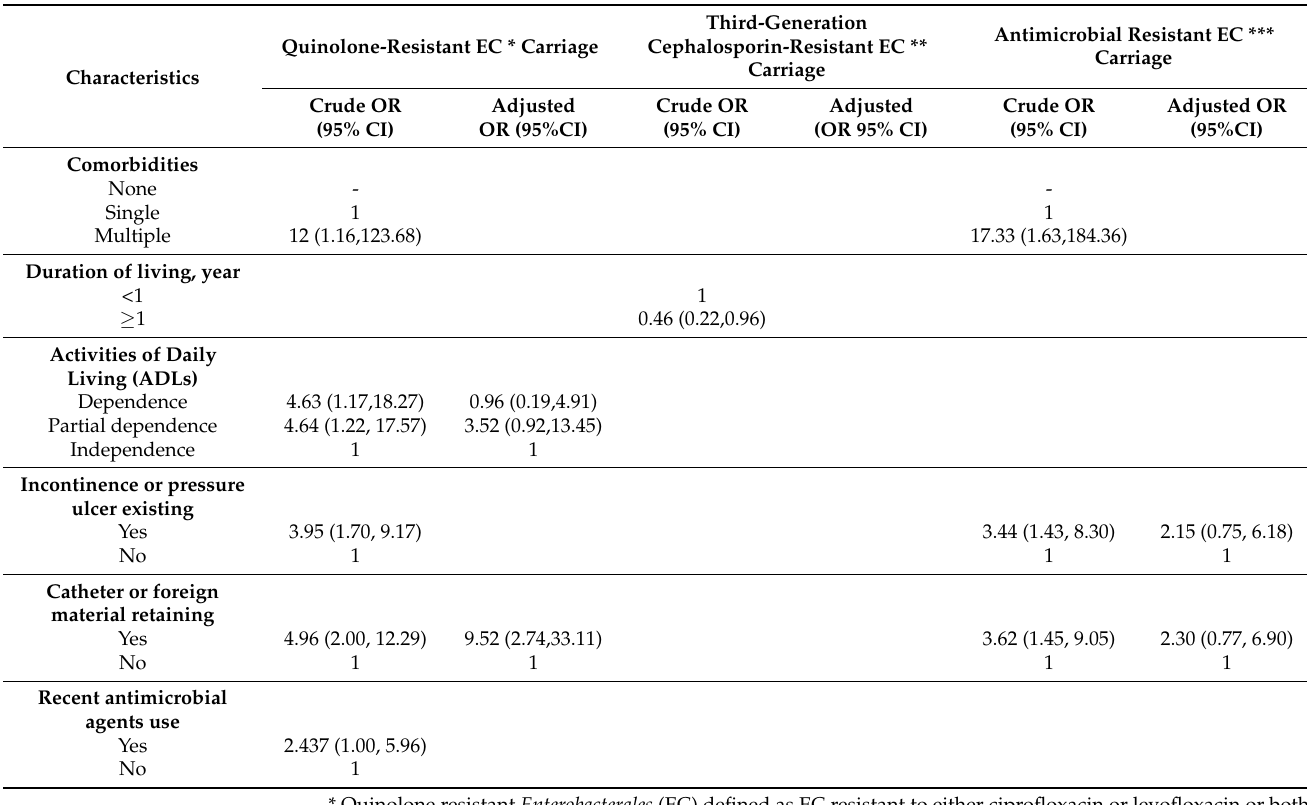
Table 2. Factors associated with antimicrobial-resistant Enterobacterales carriage of Thai nursing home residents at study